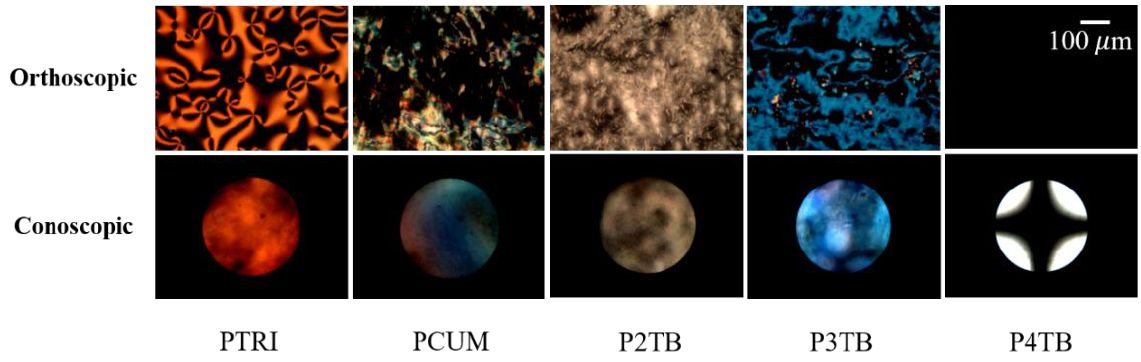
Figure 6. Orthoscopic (top) and conoscopic (bottom) POM images of LC cells made from PTRI, PCUM, P2TB, P3TB, and P4TB films.